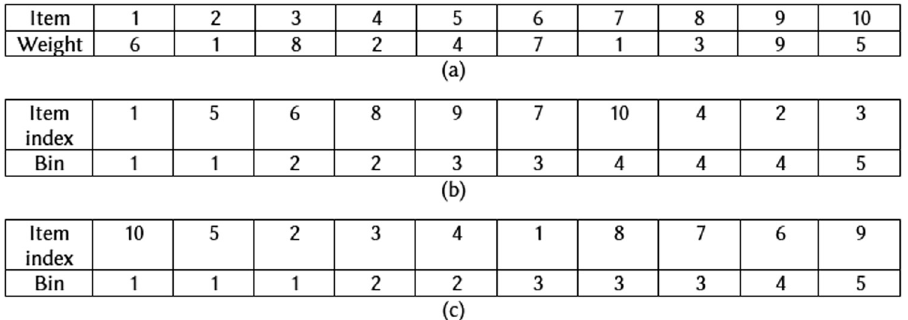
Figure 2: An example of solutions in the population illustrated in fi gure ( a ) – ( c )